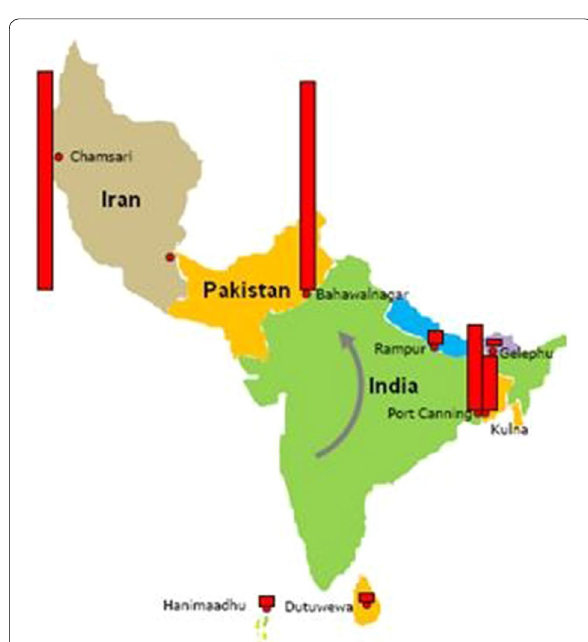
Fig. 7 Relative SO 2 concentrations in SARC